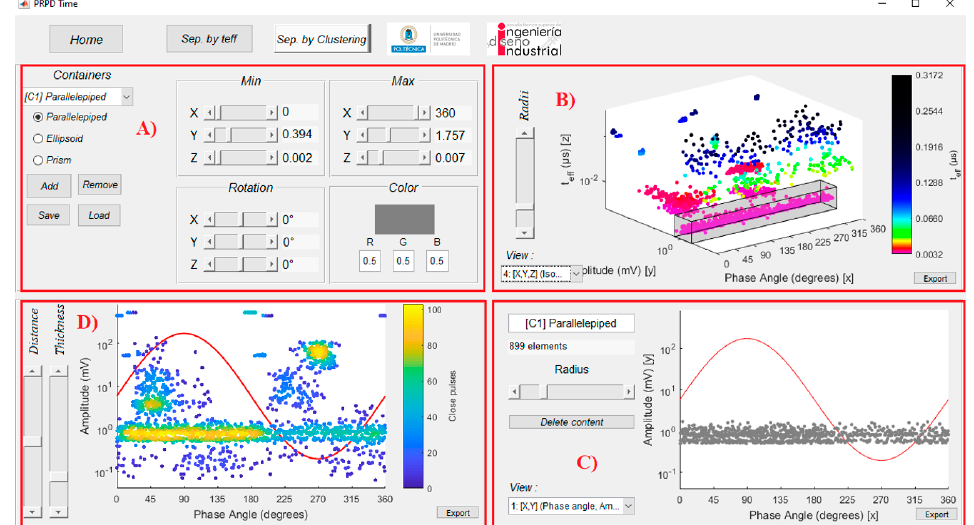
Figure 6. Graphical interface for pulses separation using the PRPD- t eff patterns. ( A ), Container definition: geometry, origin location and size; ( B ) container geometry plotted in the PRPD- t eff pattern; ( C ), pulse density pattern plot, distance and thickness controls and ( D ), PRPD pattern for pulses in container that allows the classification by clustering